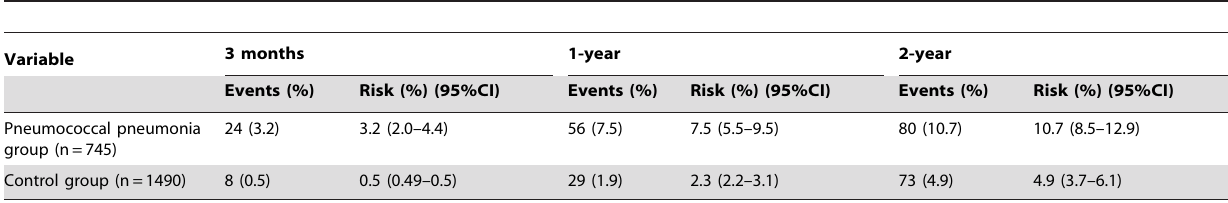
Table 2. Cumulative risk of stroke events in patients with pneumococcal pneumonia and those without.